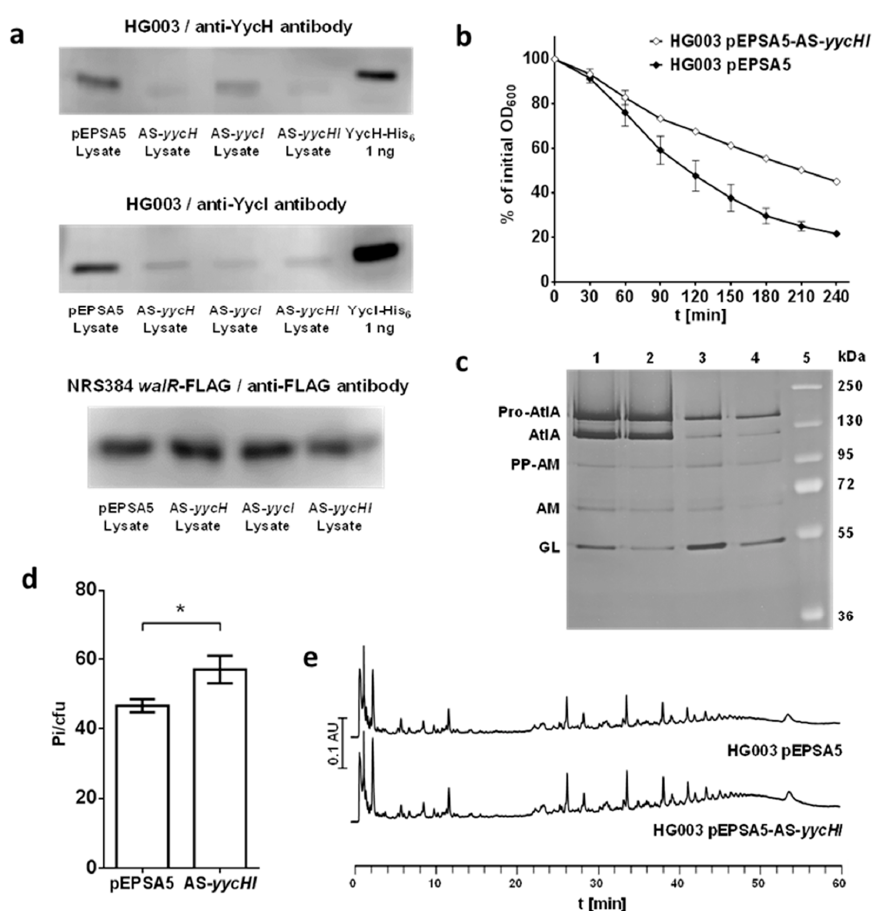
Figure 2. Characterization of S. aureus HG003 with antisense knockdown of the YycH and YycI proteins. ( a ) Western blots of S. aureus HG003 and S. aureus NRS384 walR -FLAG lysates with the pEPSA5, pEPSA5-AS- yycH , pEPSA5-AS- yycI , and pEPSA5-AS- yycHI vectors as well as recombinant YycH-His6 and YycI-His6. Antisense RNA against yycHI reduced the translation of both proteins. Knockdown of yycH reduced the abundance of YycI and vice versa. Expression of the same antisense plasmids in S. aureus NRS384 walR -FLAG showed no significant reduction of WalR abundance. ( b ) Triton strains HG003 pEPSA5 and HG003 pEPSA5-AS- yycHI were harvested in late-log phase, washed, and